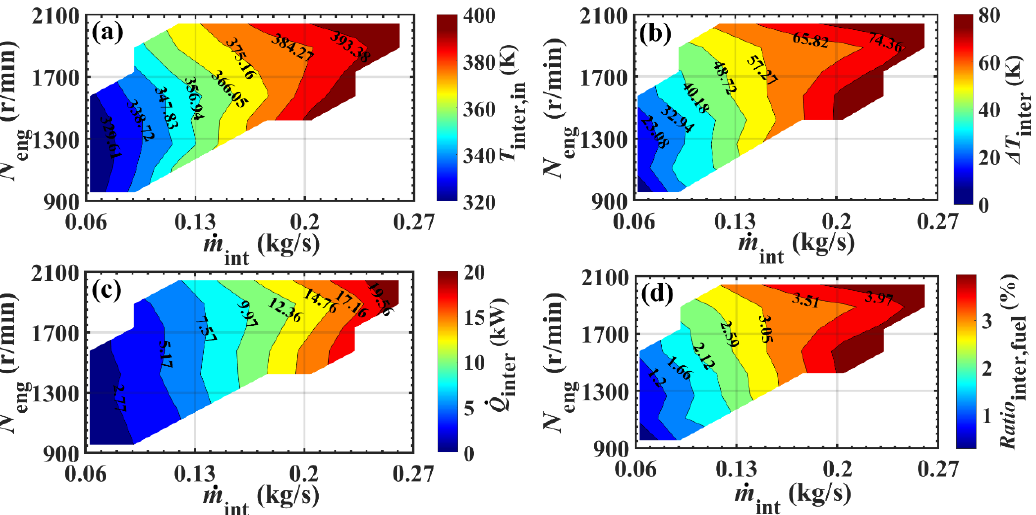
Figure 2. Waste heat characteristics of intercooler in variable working environments. ( a ) Inlet temperature of intercooler. ( b ) Temperature different of intercooler. ( c ) Heat transfer rate of intercooler. (d) Proportion of heat transfer rate in intercooler.